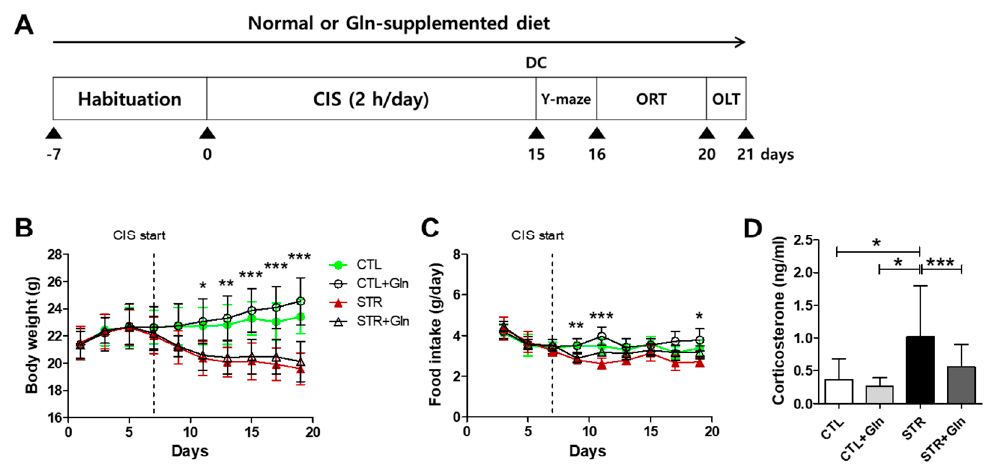
Figure 1. Chronic immobilization stress (CIS) induces stress responses, and glutamine (Gln) supplementation acts as an anti-stress agent. ( A ) Experimental schedule. Two cohorts were sacrificed after CIS for molecular analyses, and the other was used for behavioral testing. Body weight ( B ) and food intake ( C ) were recorded every 2 days for 3 weeks from day 0. ( D ) The e ff ects of immobilization stress and Gln on plasma corticosterone levels. The bars charts represent means ± SDs. * p < 0.05, ** p < 0.01, and *** p < 0.001 values in a two-way analysis of variance (ANOVA) followed by Bonferroni post-tests ( B , C ) or one-way ANOVA followed by Newman–Keuls multiple-comparison tests ( D ). CTL, control ( n = 13); CTL + Gln, Gln-supplemented control ( n = 13); DC, decapitation; ORT, object recognition test; OLT, object location memory test; STR, stressed ( n = 12); STR + Gln, Gln-supplemented stressed ( n = 13).